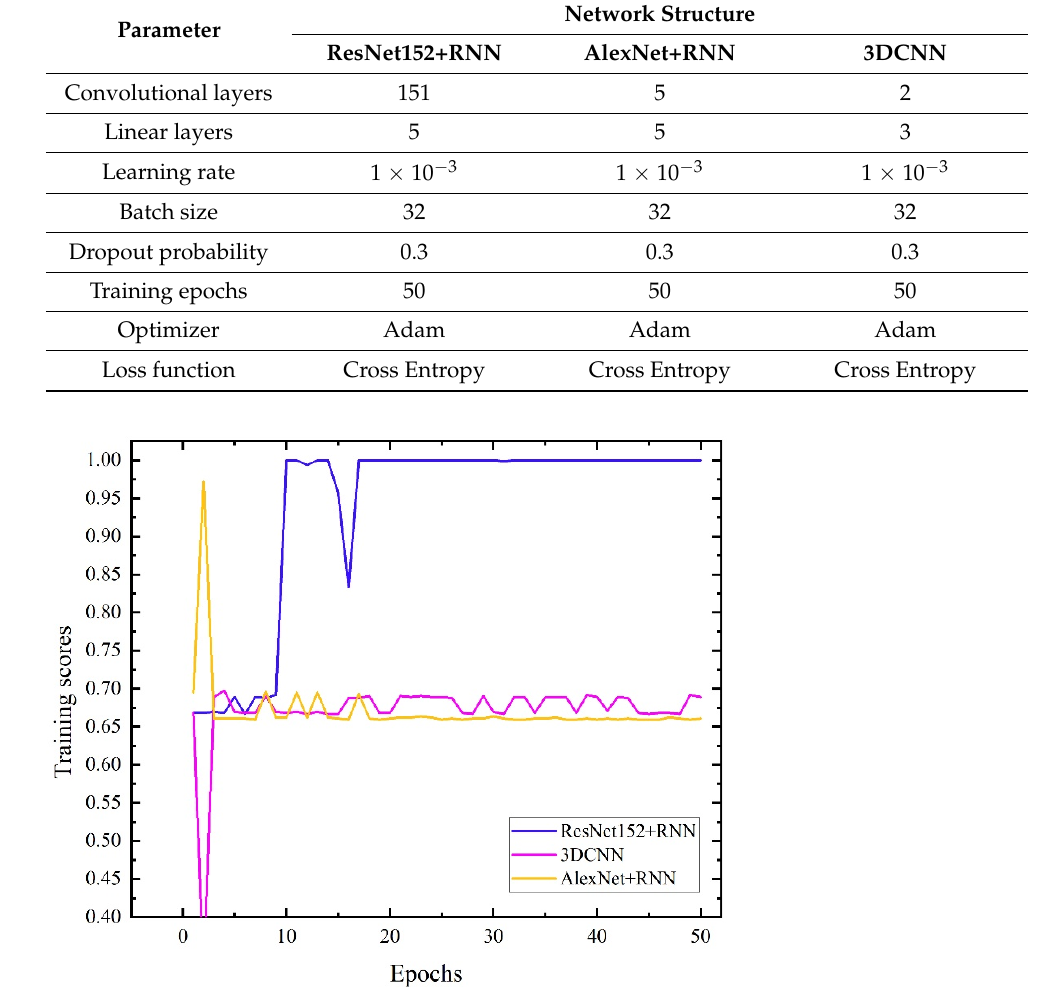
( c ) Figure 12. Confusion matrix of the three networks. ( a ) ResNet152+RNN; ( b ) AlexNet+RNN; ( c ) 3DCNN. Since the self-made massage dataset has few data categories, the data complexity is low, and additional noise will be introduced when the variational auto-encoder expands the dataset, and the designed neural network model has a complex structure and strong learning ability, it is easy to mistake the error of the data in the training set as the general law of the data itself, resulting in the phenomenon of overfitting and a decrease in the generalization ability of the model. Therefore, it is necessary to set the dropout probability of parameters in the training process to weaken the network’s learning of data errors, or